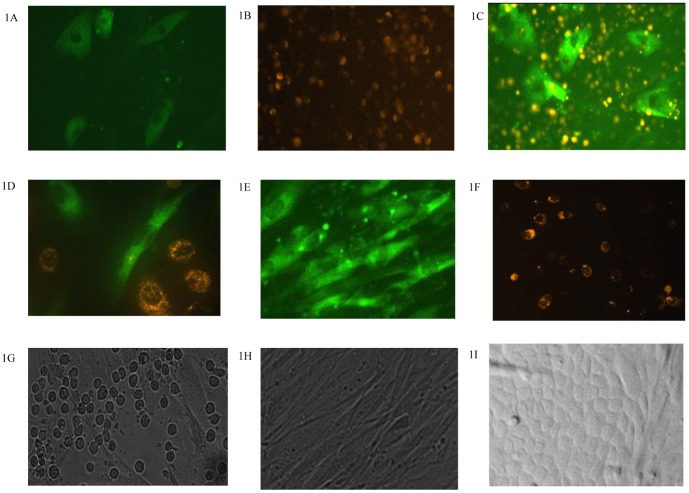
Keratinocytes and fibroblasts in cultures.3×105 fibroblasts, stained with PHK2 (green), were cultured in 6-well pre-coated plate for 48 hours (1A and 1C), and then 1×106 keratinocytes, stained with PHK26 (orange), were seeded into the wells with (1C) or without (1B) fibroblasts. After 2 days, keratinocytes were also attached on the bottom of the well (1D). On day 10, fibroblasts tended to cover the entire bottom of the well (1E) but keratinocytes did not proliferate very much (1F). In the co-culture, significantly more keratinocytes (round cells) were growing on the fibroblast layer (1G). On day 15, the overgrowing fibroblasts resulted in some cells grew on others (1H), while keratinocytes could still form the skin-like layer on the top of fibroblasts (1I). 1A–1F were under fluorescence microscope (x200 or x400), 1G, 1H and 1I were under regular light microscope (x200), and natural light were used for 1I(x200).